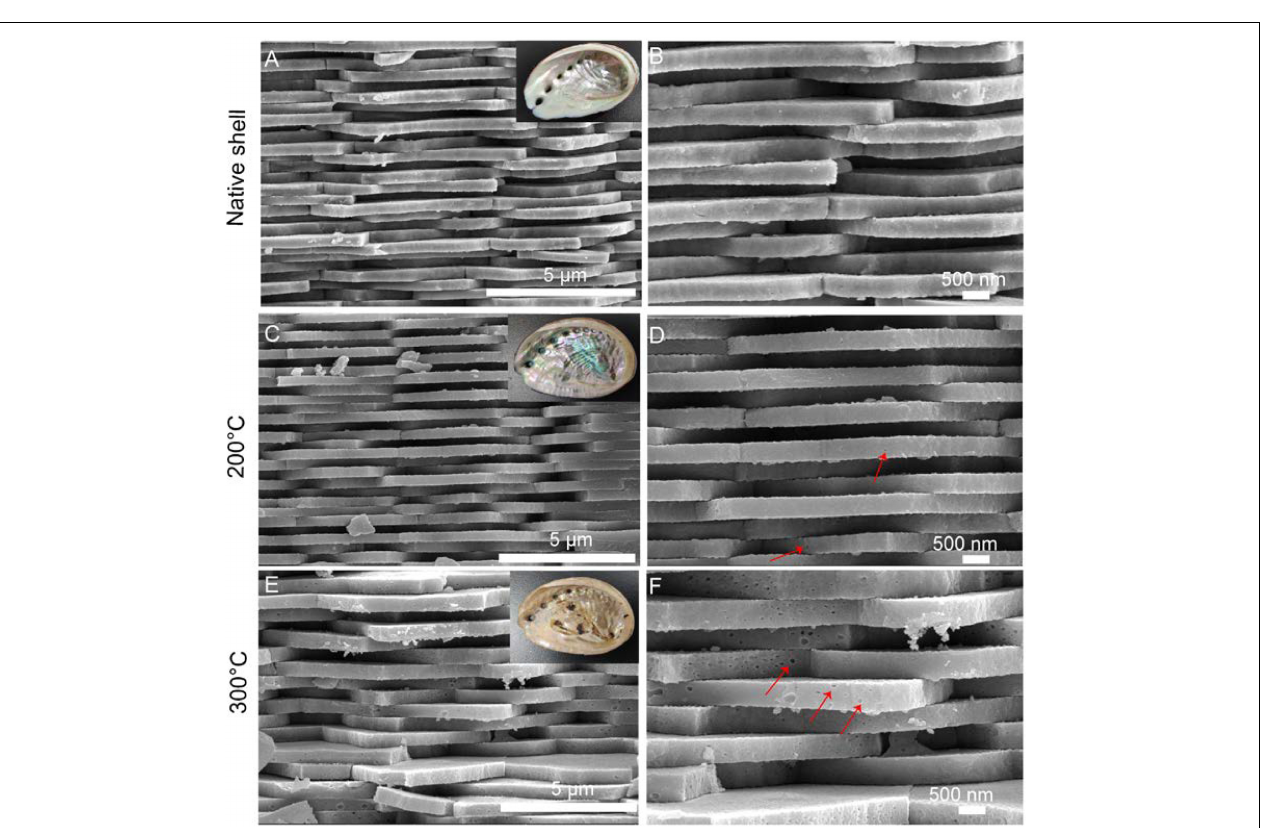
FIGURE 2 | Microstructure of the native and toasted abalone shell by SEM. (A) Native abalone shell and its magnification (B) ; toasted abalone shells at 200 ◦ C (C) and 300 ◦ C (E) and their magnification (D,F) respectively. Red arrows indicate the nanoscale holes in the nacre tablets. The insets in (A,C,E) are the optical images of